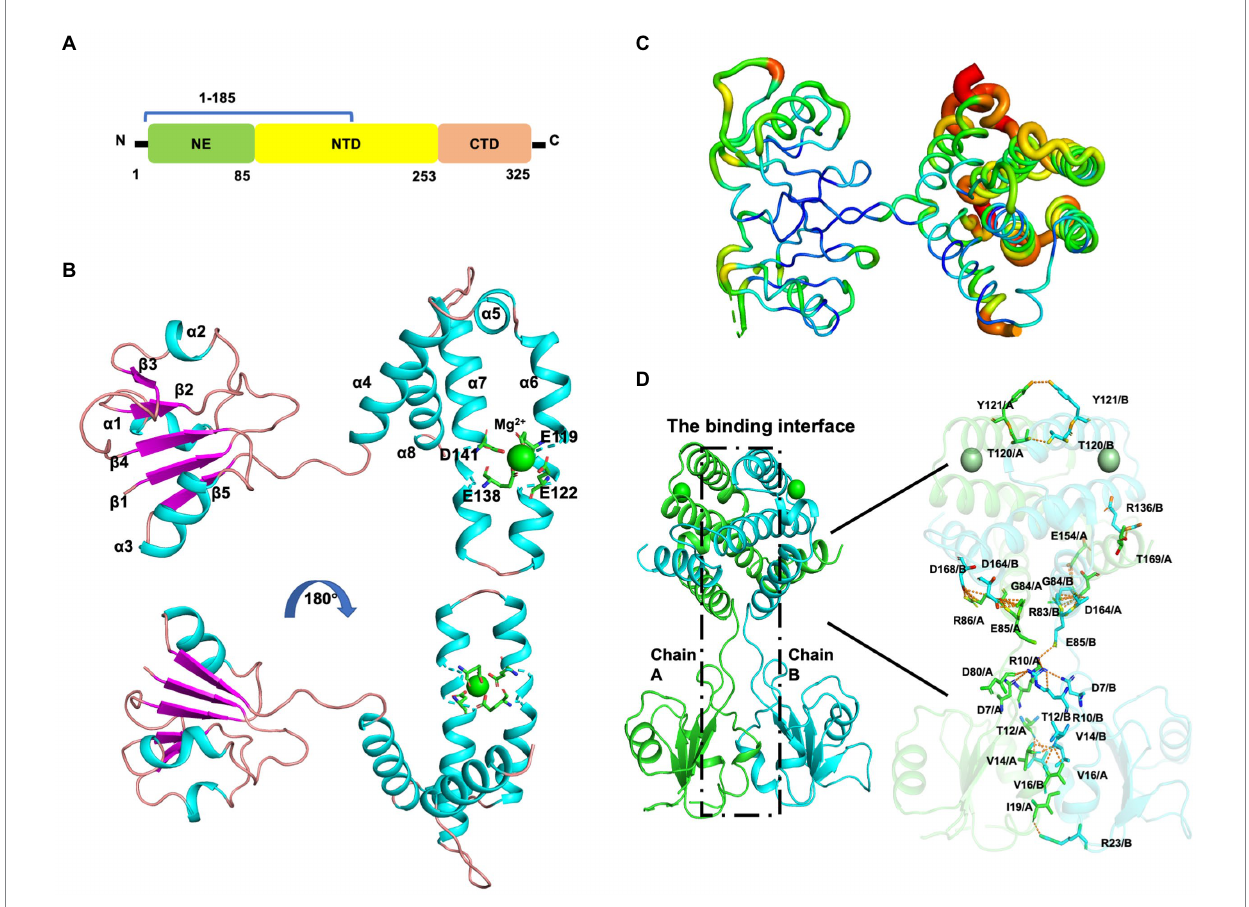
FIGURE 2 The overall structure of MazG (1–185) from Mycobacterium tuberculosis . (A) Schematic of the Mtb-MazG protein. Mtb-MazG is composed of the N-terminal domain (NTD), the C-terminal domain (CTD), and the N-terminal extra region (NE). (B) The crystal structure of Mtb-MazG (1–185) is represented by a cartoon model, which is composed of eight α -helices and five β -strand. The magnesium is bound with four residues that are located on α 6 and α 7 of MazG (1–185). Cyan: α -helix; magenta: β -strand; green: magnesium ion. (C) The B-factor distribution of Mtb-MazG protein. The wider and redder tubing indicated a higher B-factor. (D) The binding interface between the swapped-dimeric Mtb-MazG (1–185). The dashed black box (left) denotes the interface between the swapped dimeric structure. The key residues (right) involved in the interface are shown in stick models. Magnesium ions are shown in green